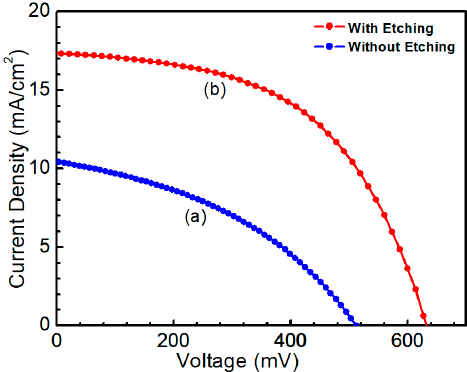
Figure 11. J-V curve of CZTS solar cells ( a ) without etching ( b ) etching for 10 min.